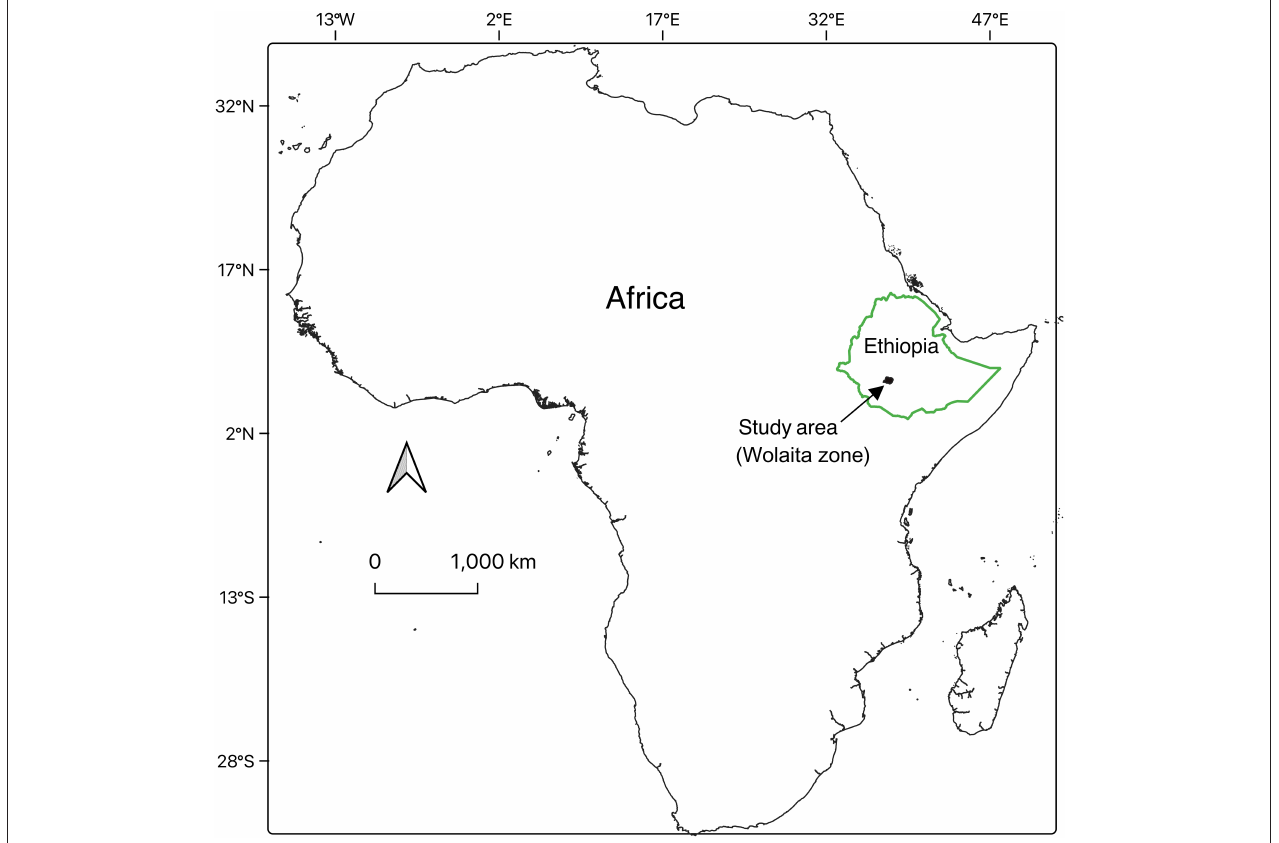
FIGURE 1 | Map of the study area.